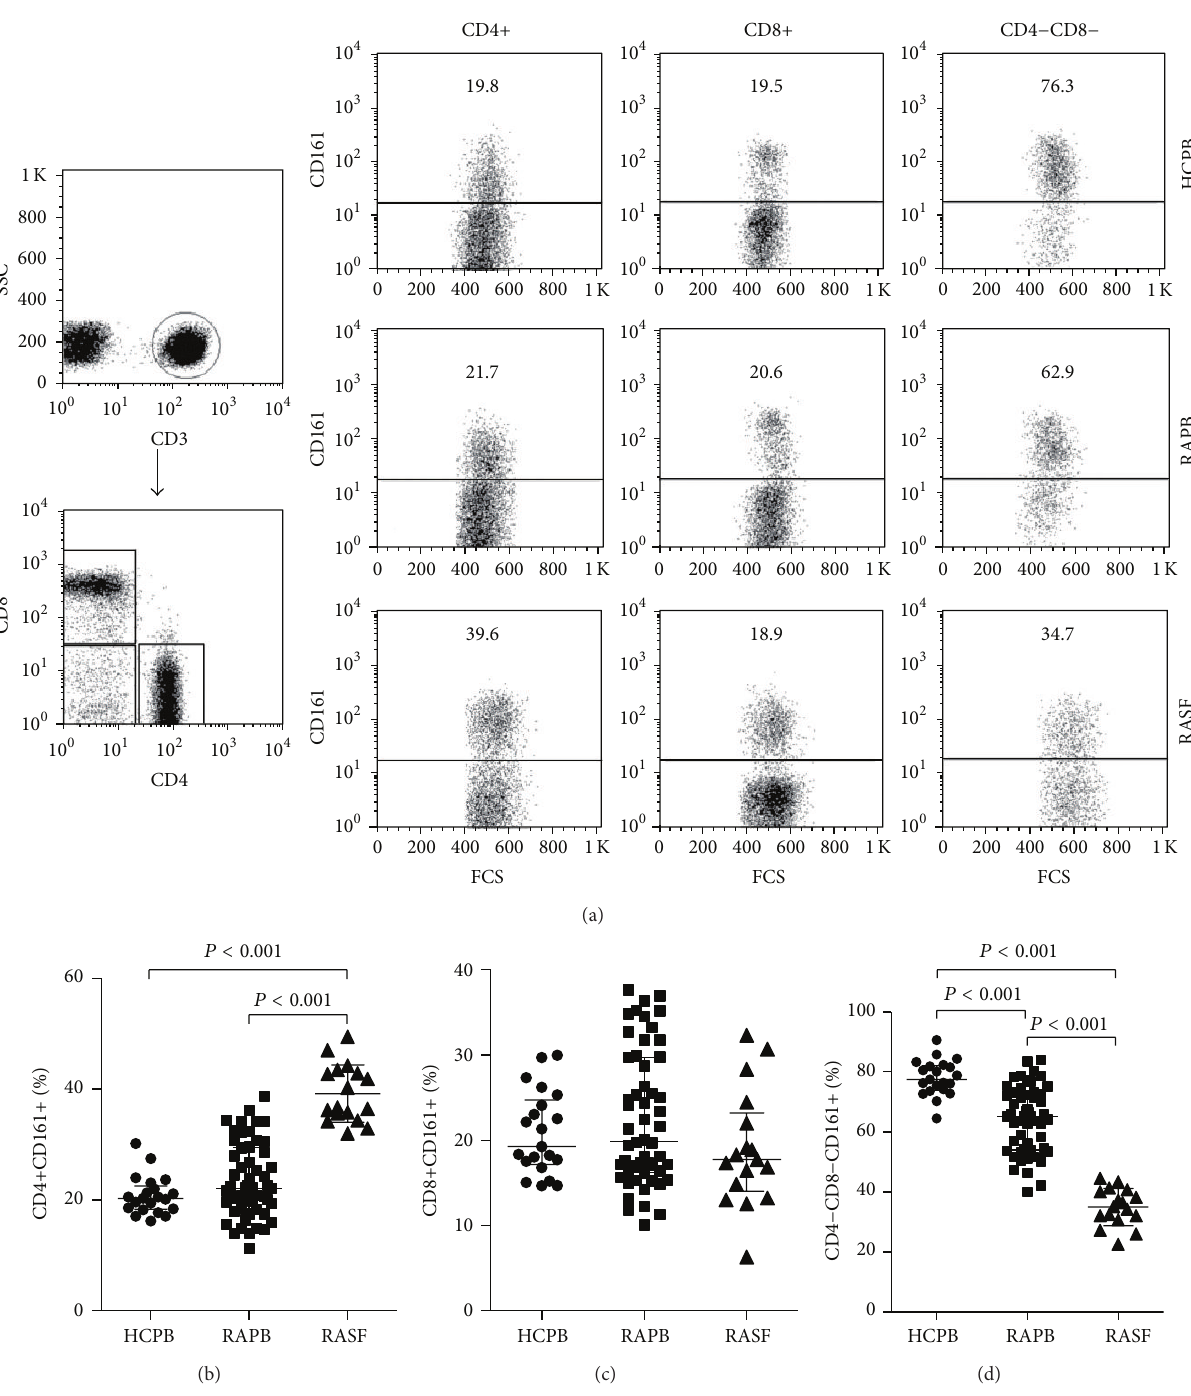
Figure 1: Presence of CD161+ T cell subsets in RA patients and HC. (a) Flow cytometric dot-plots show gating strategy: CD3+ T cells were gated using side scatter profile and the expression of CD3; then CD4+, CD8+, and CD4 − CD8 − T cells were gated based on their expression of CD4 and CD8, and the CD161 expression levels in these T cell subsets were analyzed from representative HC peripheral blood (PB), RA PB, and RA synovial fluid (SF). Percentages of CD4+CD161+ (b), CD8+CD161+ (c), and CD4 − CD8 − CD161+ T cells (d) in HC PB, RA PB, and RA SF. Horizontal line indicates median value. P values were assessed by Mann-Whitney U